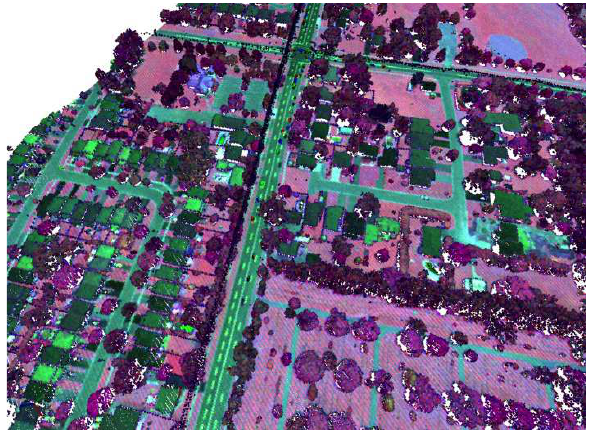
Figure 1. Merged point cloud coloured as false-colour composite (red=C2, green=C3 and blue=C1)